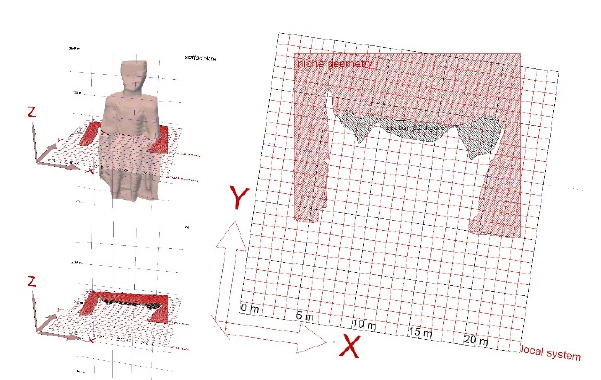
Figure 4. Steps to determine the contour outline of the destroyed 38m Buddha figure in relation to the existing niche – average distance from the rear wall about 1.7-2m.